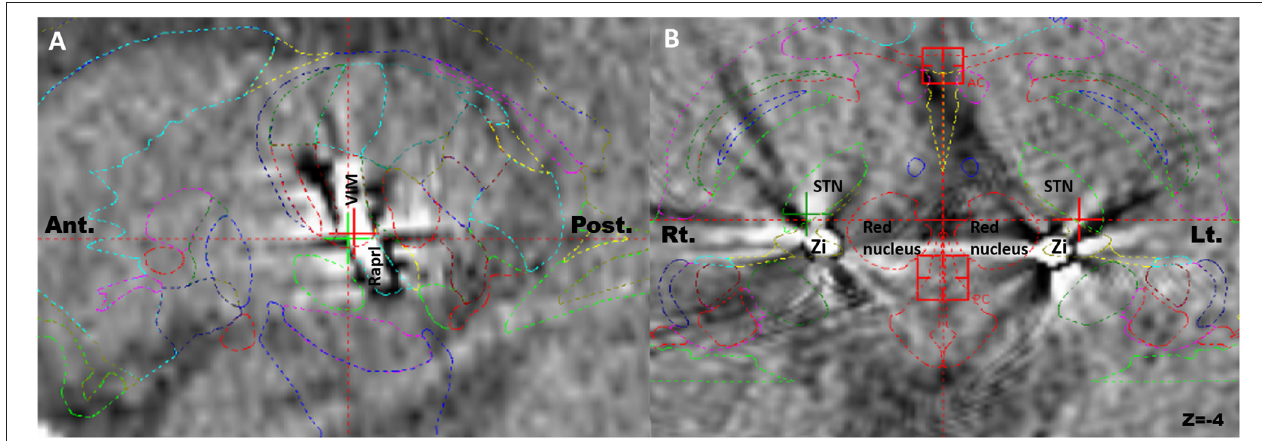
FIGURE 1 | Postoperative computed tomography scans merged with preoperative magnetic resonance images for identification of the actual electrodes and active contacts using Schaltenbrand atlas. (A) The electrode hit the ventralis intermedius and the prelemniscal radiation simultaneously in the sagittal plane. (B) The tips of bilateral electrodes were located in the zona incerta in the axial plane. Ant, anterior; Post, posterior; Rt, right; Lt, left.